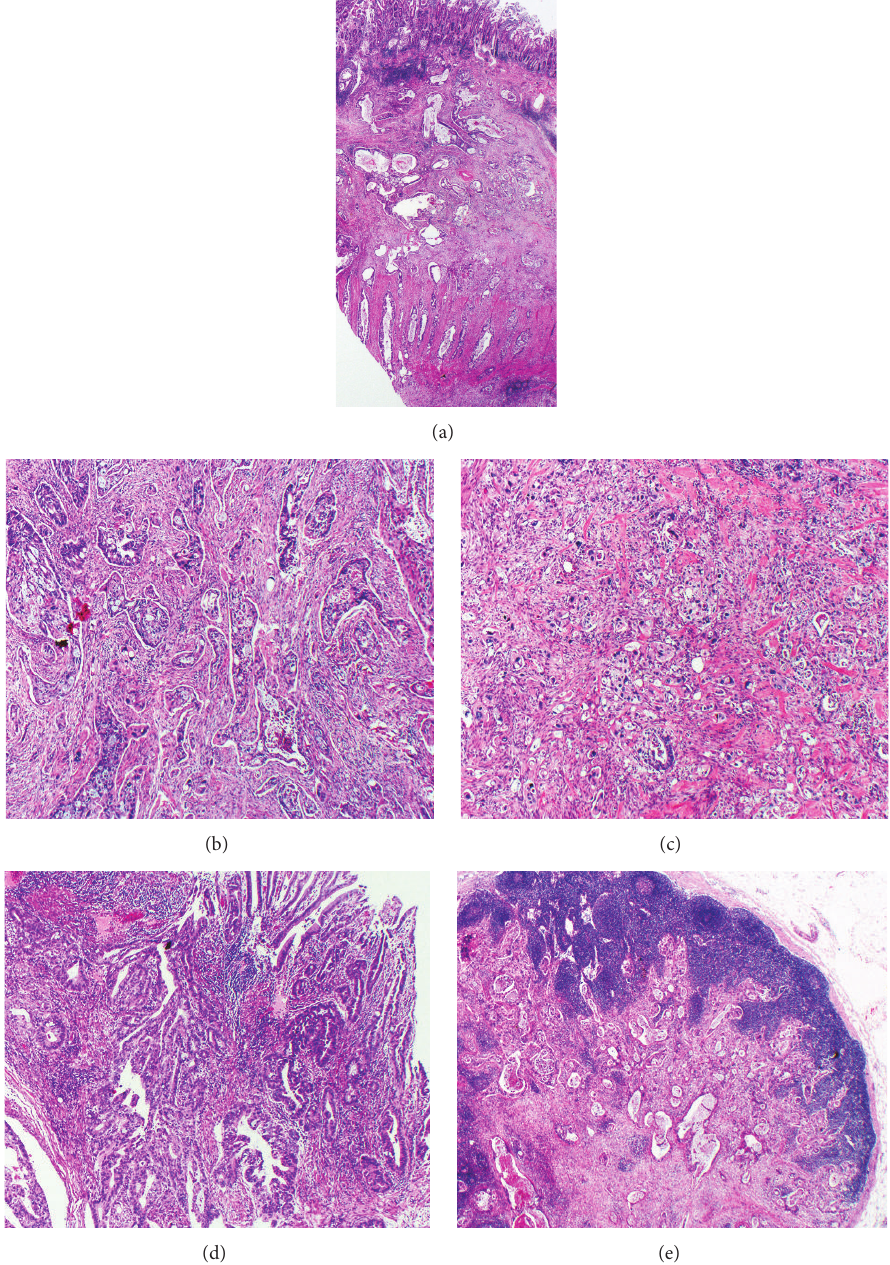
Figure 1: H&E stained sections of grade 2 (moderately differentiated) adenocarcinoma extending through the muscularis propria (pT3). (a) Full-thickness section of the tumor. Adjacent to the tumor and deep to the tumor are lymphoid aggregates composed of tumor infiltrating lymphocytes (20x), (b) areas of tumor highlighting predominantly moderate differentiation (40x), (c) areas of tumor highlighting poor differentiation comprising less than 5% of the overall tumor (40x), (d) tumor originating from surface epithelium (40x), (e) and lymph node metastasis